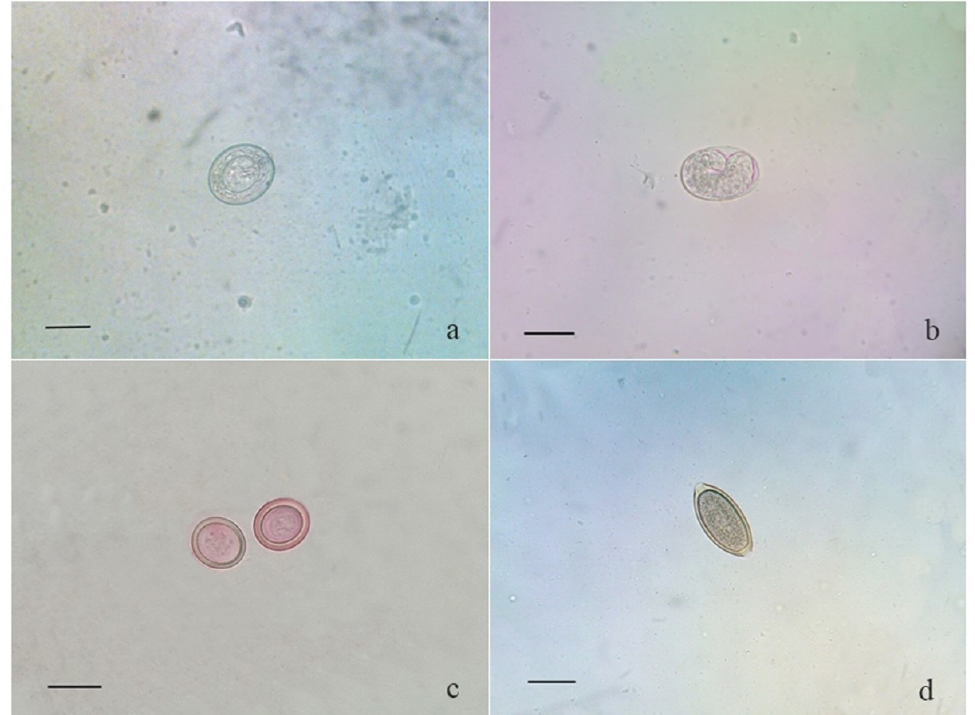
Figure 1. Helminth and cestode eggs detected by FLOTAC in wild and synanthropic rodents in Brazil (Scale bar = 25 µ m). (a) Hymenolepis nana: oval egg, 40-60 µ m long and 30-50 µ m wide, containing oncospheral hooks and polar filaments within the space between the oncosphere and outer shell; (b) Strongyloides spp.: thin-shelled oval egg, 40-50 µ m long and 30-34 µ m wide. (c) Taenia spp.: oval egg, 30-40 µ m long and 30-40 µ m wide, containing a hexacanth embryo; (d) Trichuris spp.: bar-shaped colorless thick-shelled egg, 48-62 µ m long and 29-37 µ m wide, with bipolar plugs, with 400x objective in optical